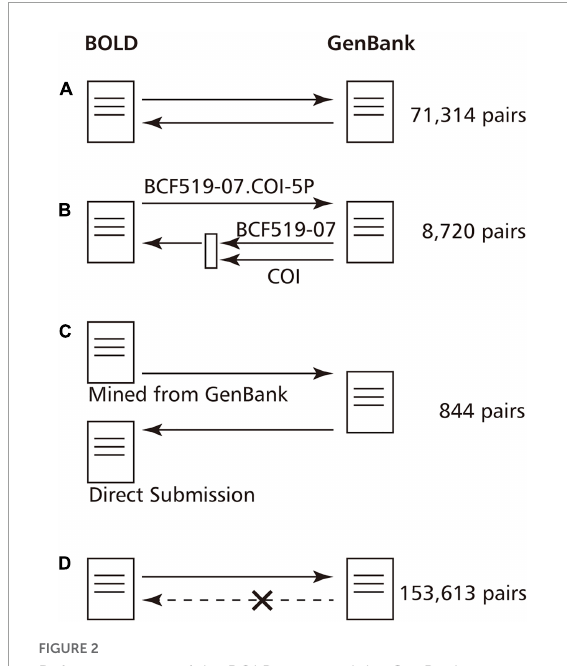
FIGURE2 Reference status of the BOLD entry and the GenBank entry to each other. Since GenBank and BOLD import data from each other, their IDs are often mentioned in their entries. However, the references may not be reciprocal due to ambiguity in the description or duplicate registrations. (A) ID references are reciprocal. (B) GenBank refers to the ID of the specimen from which the DNA barcode is derived, but the BOLD Barcode ID can be recovered by extracting the gene name as well. (C) The case where the ID of a direct submission and the import data exist because the data were registered in both GenBank and BOLD. In past examples, these will be unified later. (D) BOLD ID is not described in GenBank.